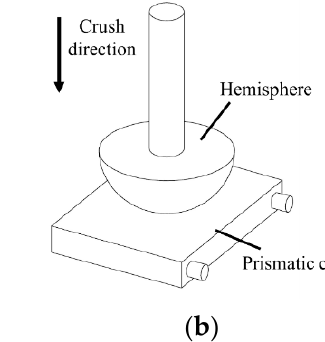
( a ) ( b ) Figure 2. Schematic diagram of the crushing plate: ( a ) form 1; ( b ) form 2. 2.2.5. Penetration Test The penetration test is used to test the battery safety by drilling a steel needle into a LIB at a certain speed [92,93]. In SAE J2464-2021 [72] and SAND2005-3123 [75], a 3-mm- diameter steel needle penetrates the single cell with a speed of 8 cm/s until the battery is fully pierced. For battery modules and packs, it is penetrated with a 20-mm-diameter steel needle, which needs to pierce at least 3 cells or the penetration depth needs to reach 100 mm. Although GB 38031-2020 [84] does not require a penetration test for a single cell, the TR propagation test is carried out on the battery pack or system. The TR triggering method of a cell can be selected for steel needles with a diameter of 3 – 8 mm, whereby the angle range of the needle tip is 20 – 60° and the needling speed range is 0.1 – 10 mm/s. 2.2.6. Rollover Test The rollover test is used to evaluate the battery safety when the vehicle is rotated [59]. In SAE J2464-2021 [72] and SAND2005-3123 [75], it is required to first turn the test battery at 360°/min for one cycle, then turn it around at 90° increments and hold each position for 60 min. In UL 2580-2020 [77], a fully charged battery is flipped at a speed of 90°/15 s, and it needs to be rotated 360° in 3 different directions that are perpendicular to each other.